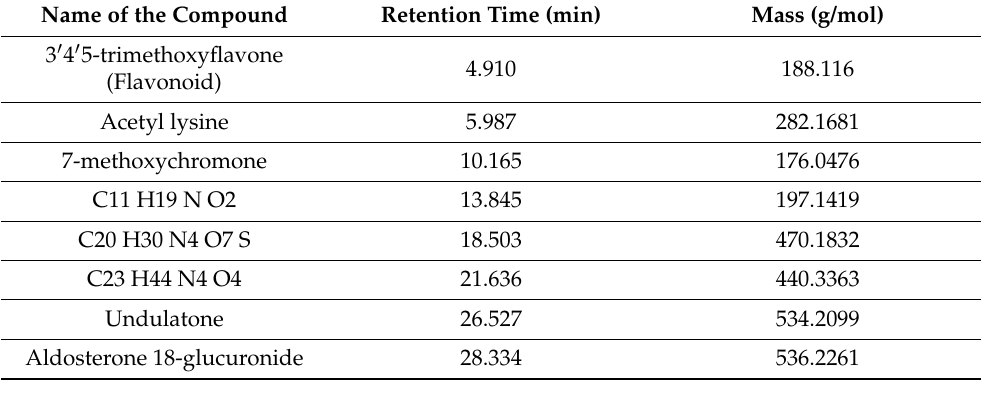
Table 6. Bioactive compound identified from E. tapos shell extract by LC-MS.